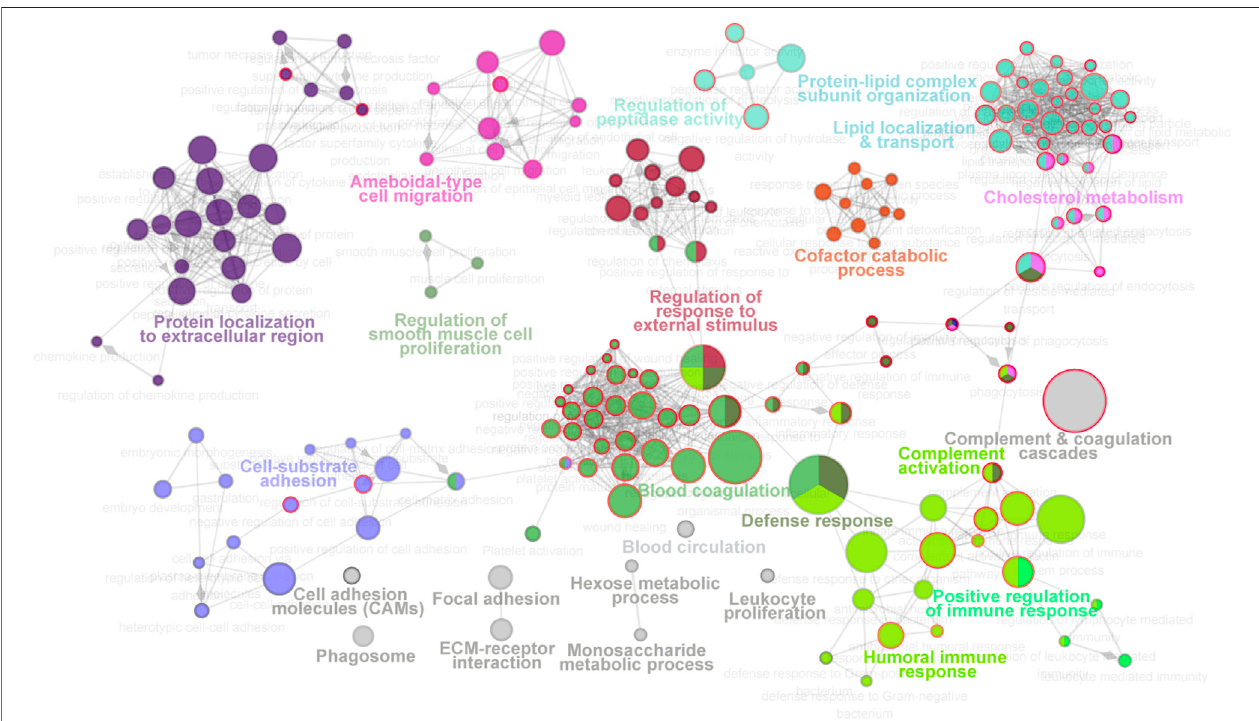
FIGURE3| Molecularfunctionlandscapeofallproteins identi fi edinproteomicsand glycoproteomics.Pathwayinteraction networkofallproteinswasconstructed by the ClueGO app in Cytoscape software, based on Gene Ontology (GO), Kyoto Encyclopedia of Genes and Genomes (KEGG), and Reactome data resources. The pathways are connected based on the kappa score. The functional network modules are de fi ned using the kappa score and annotated with different colors. For each module,themostsigni fi cantpathwayishighlightedbyacolorednamelabel.Thesizeofthenodesindicatesthenumberofidenti fi edproteinswiththispathway.The pathways speci fi cally enriched in glycoproteomics are labeled with a red node